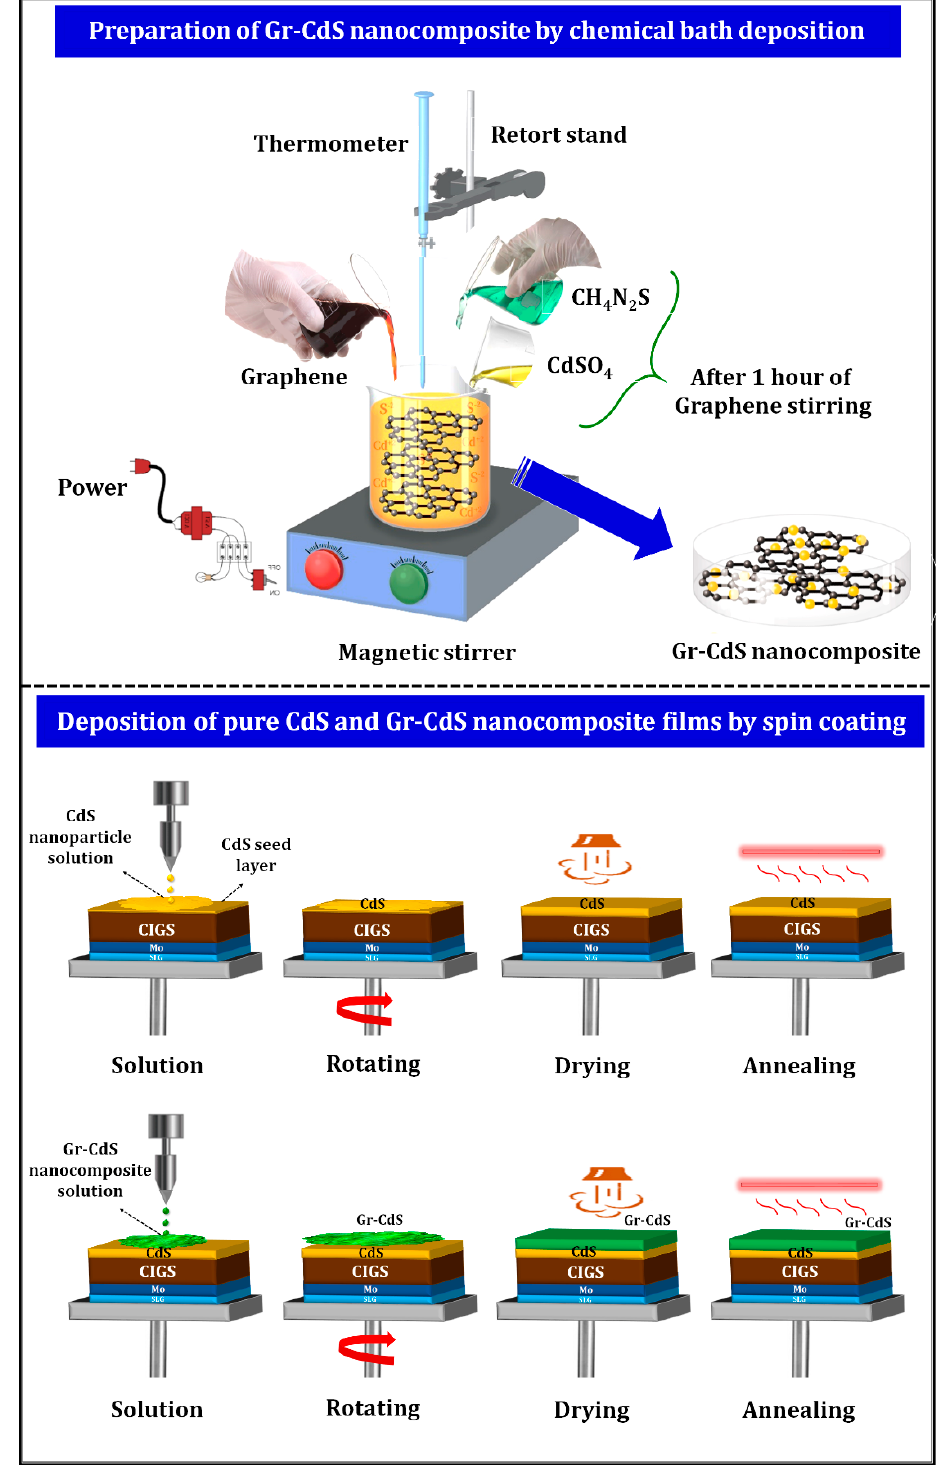
Figure 1. Schematic of the deposition of CdS nanoparticles (NPs) and Gr–CdS nanocomposite films.